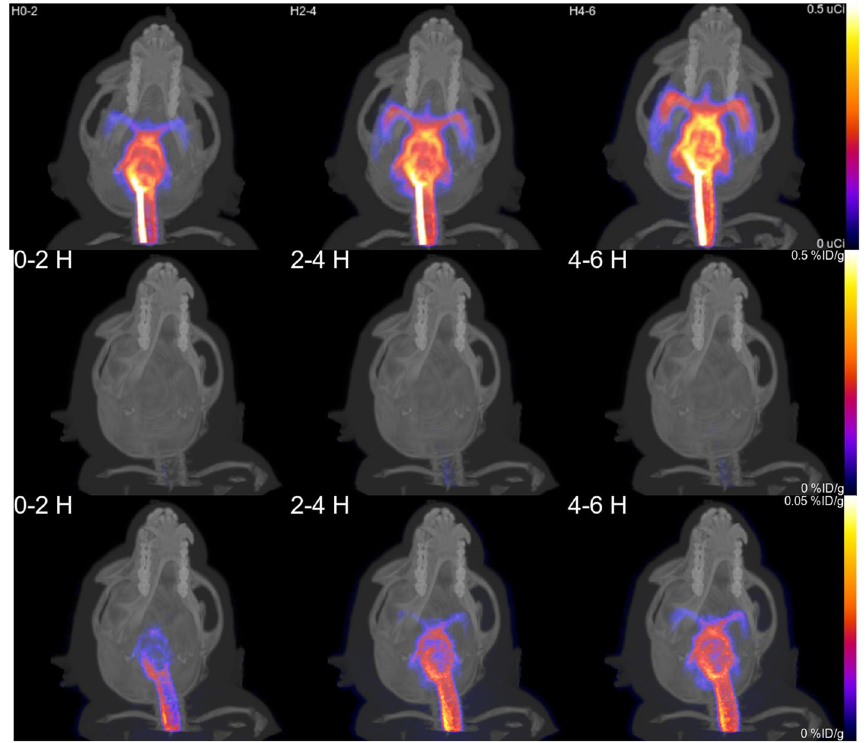
Fig. 2 Summed images acquired at 0–2, 2–4 and 4–6 hours following the start of administration with the catheter tip at the first cervical vertebra (C1) (top) and the tenth thoracic vertebra (T10) (middle) demonstrating the delayed distribution within the brain following delivery in the thoracic spine compared to the cervical spine. The color scale is identical for the top and middle panels (0-0.5% ID/g). The bottom panel is the same figure as the middle panel but with a different color scale (0-0.05% ID/g) demonstrating that activity is present in the brain, but in lower amounts. The low intensity in the middle panel demonstrates that there is much less activity in the brain with the T10 catheter placement and that the low tracer distribution was potentially offset by clearance rates. We used the same color scale for the top and middle panels in order to illustrate this marked difference. To demonstrate that there is indeed radioactivity in the middle panel, the color scale for the bottom panel has been changed to a range that demonstrates the lower activity (0-0.05%